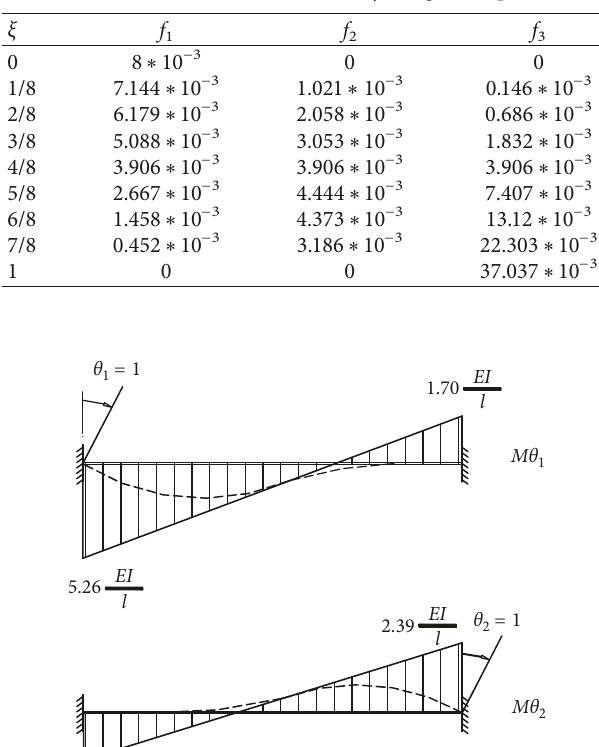
Table 1: Values of the function Z